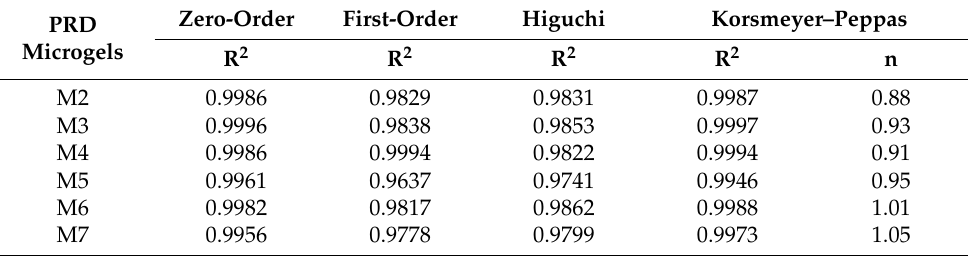
Table 12. Values of calculated coefficient of determination (R 2 ) and exponent of release mechanism (n) from the release data of M 2-7 microgels using the zero-order, first-order, Higuchi, and Korsmeyer– Peppas